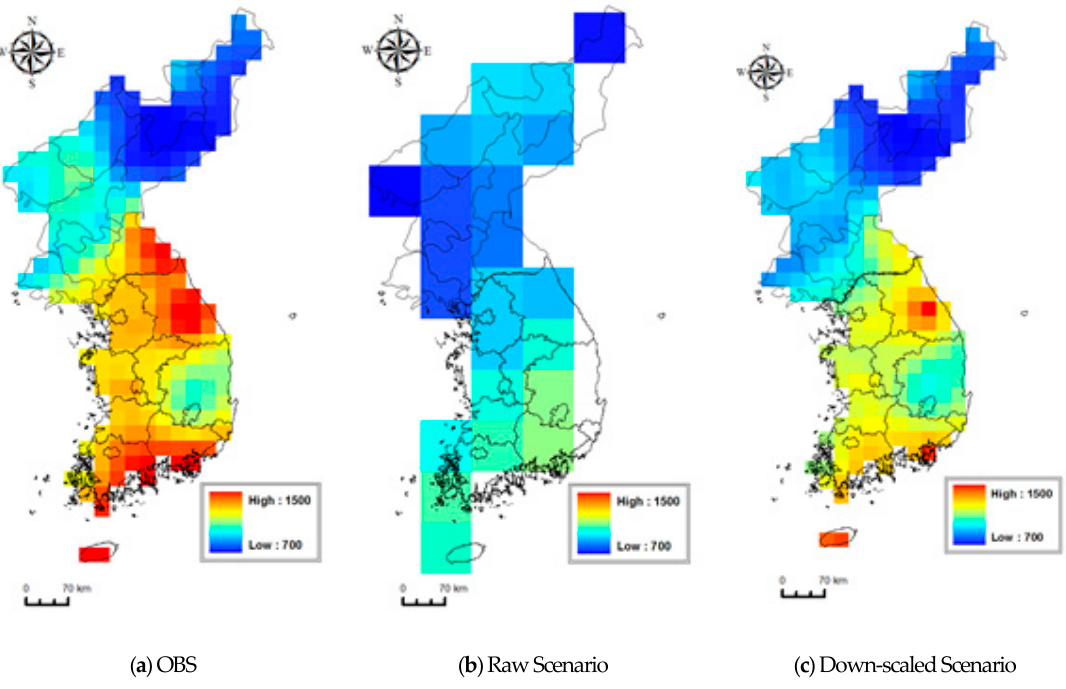
Figure 7. Spatial distribution for observation and before / after down-scaling (annual precipitation). ( a ), ( b ), and ( c ) represent OBS, Raw-Scenario, and Down-scaled Scenario respectively.